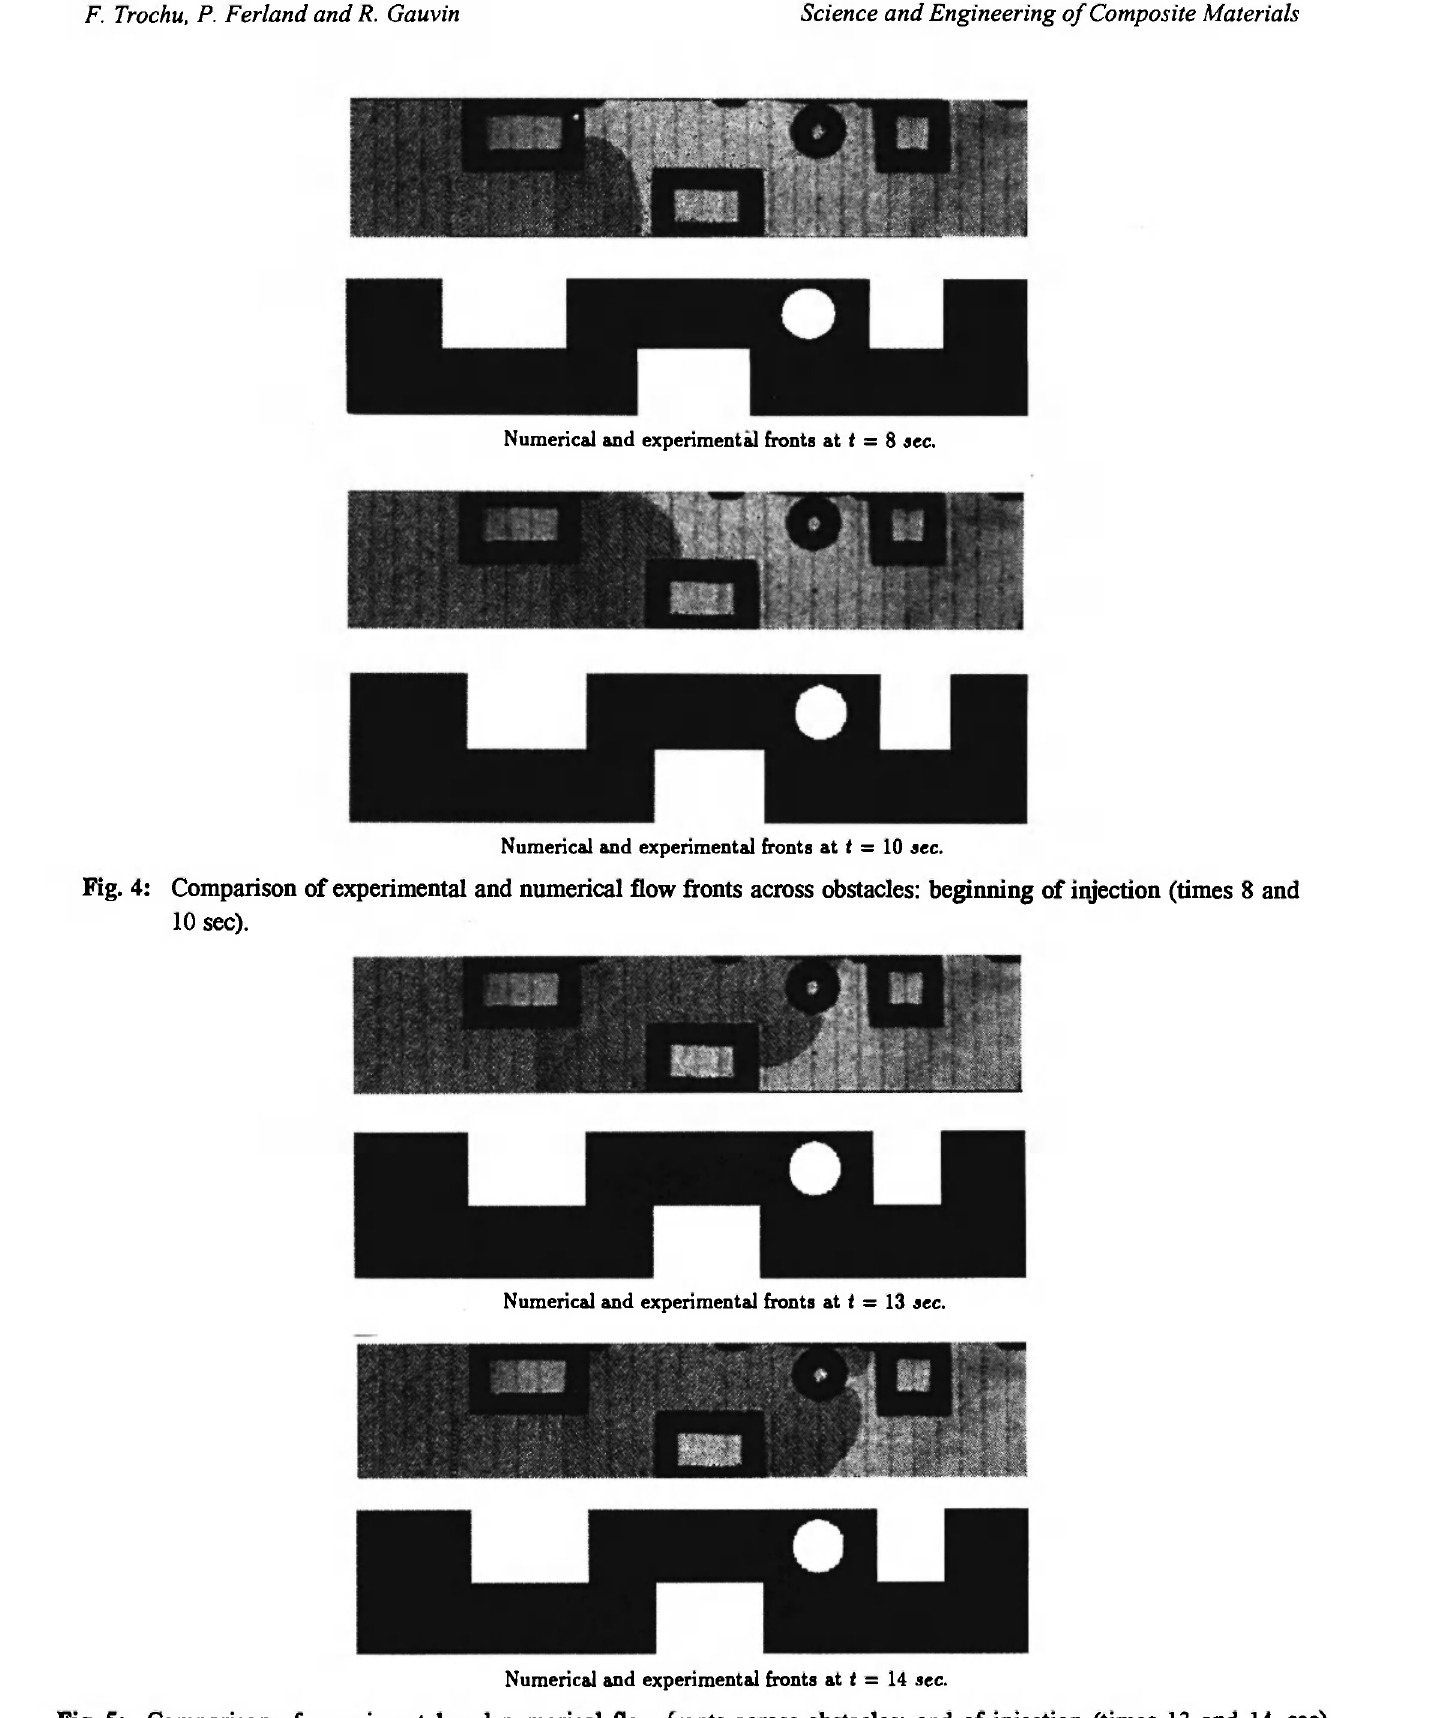
Fig. 5: Comparison of experimental and numerical flow fronts across obstacles: end of injection (times 13 and 14 sec).